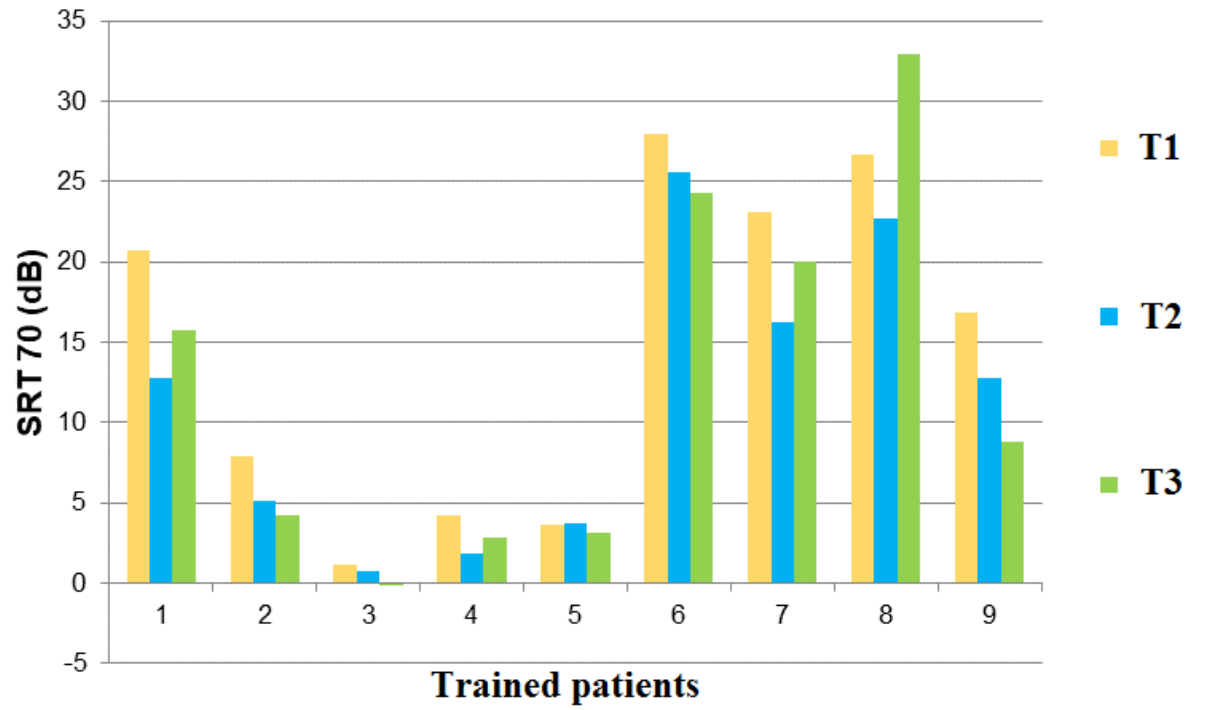
Figure 4. Changes over time in signal-to-noise ratio (dB) at a 70% speech reception threshold for nine subjects of the study group, 5 weeks after serious game-based AT (green).